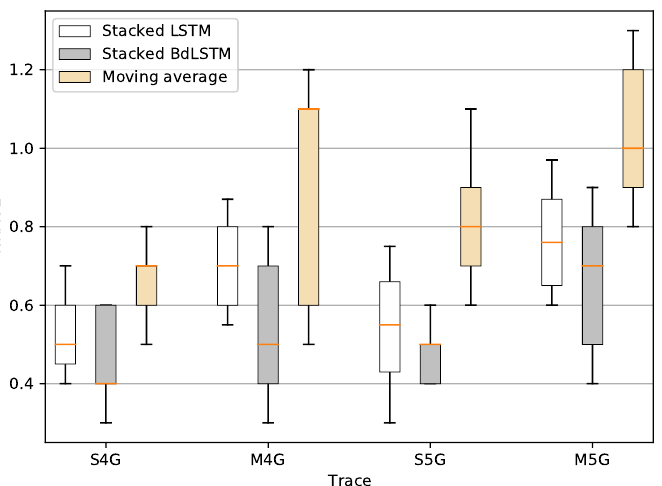
Figure 7. NRMSE of the analyzed prediction models for different traces. Every box on the plot represents predictions made on ten overlapping sub-traces every 30 minutes, which were extracted from traces listed in Table